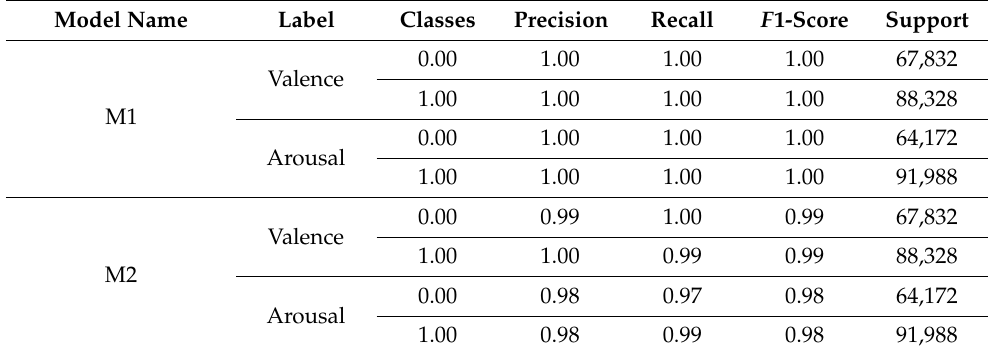
Table 9. Performance report for M1 and M2 models with binary classification for 75/25 train–test